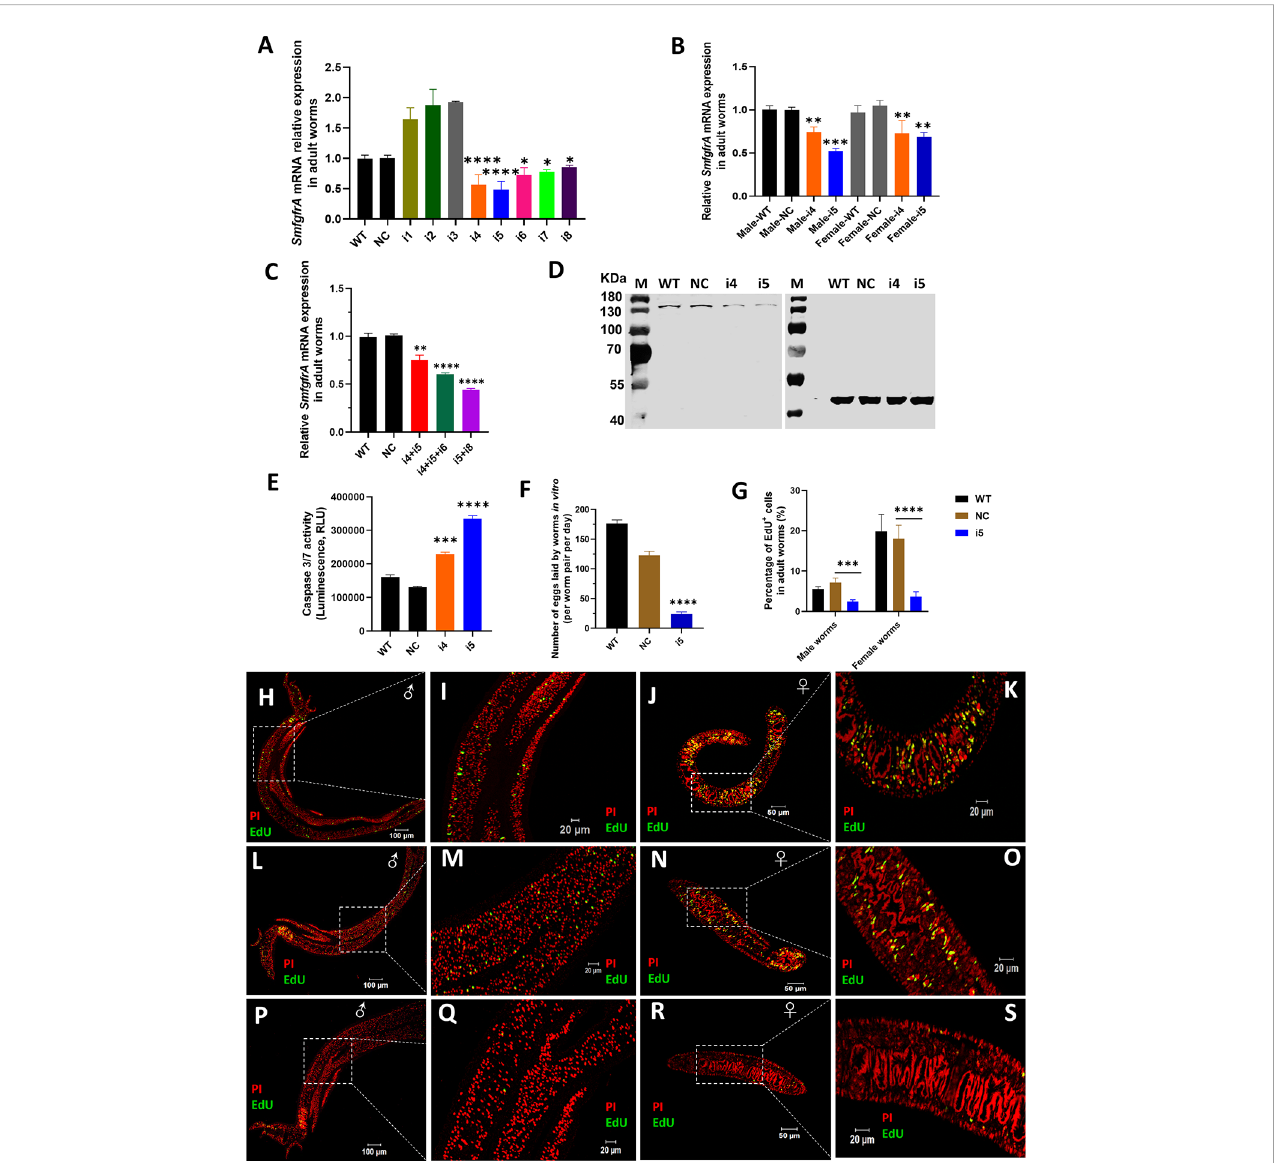
FIGURE 2 CRISPRi of SmfgfrA in S. mansoni adult worms. Transcription level of SmfgfrA was determined in (A) paired adult worms electroporated with a CRISPRi vector (PHR-SFFR-dCas9-BFP-KRAB) combined with reconstructed pg-RNA vector containing sgRNA (i1, i2, i3, i4, i5, i6, i7, i8), individually; (B) adult male and female worms treated with sgRNA i4 or i5; (C) paired worms treated with sgRNA i4+i5, i4+i5+i6, or i5+i8. Wild-type (WT) worms and worms treated with CRISPRi vector combined with pg-RNA vector containing a negative control (non-targeting) sgRNA (NC) were used as controls. Experiments in panels (A – C) were performed in triplicates and all data are shown as the mean ± SE. (D) Western blot demonstrating expression level of SmFGFRA protein in soluble worm antigen preparation (SWAP) of WT adult worms (Lane 1) and worms treated with NC (Lane 2), i4 (Lane 3) or i5 (Lane 4). An anti- actin antibody was employed to ensure equal protein loading. The electrophoresed SWAPs were transferred for the western blot analysis to two PVDF membranes which were probed simultaneously with the anti-rSmFGFRA-L antibody (left blot) and the anti-actin antibody (right blot). (E) Caspase-3/-7 activity measured in i4 and i5-treated adult worms. This assay was conducted in duplicate with all data presented as the mean ± SE. (F) The number of eggs laid by WT adult worms, NC-treated adult worms or i5-treated adult worms in vitro. This experiment was conducted in triplicates with all data shown as the mean ± SE. (G) The effect of SmfgfrA repression on the percentage of EdU + cells in i5-treated male worms and female worms. WT and NC-treated male and female worms were used as controls. Cell nuclei in all samples were also stained with Propidium iodide (PI). Percentage of EdU + cells in each sample was calculated by dividing the EdU + cell number with PI + cell number X 100. All data are shown as the mean ± SE (WT male worm: n=13, WT female worm: n=8, NC male worm: n=12, NC female worm: n=8, i5 male worm: n=10, i5 female worm: n=15). Confocal projections representative signals of EdU (green) and PI (red) in (H) WT male worm, (J) WT female worm, (L) NC-treated male worm, (N) NC-treated female worm, (P) i5-treated male worm and (R) i5-treated female worm. (I, K, M, O, Q, S) are magni fi ed squared-region in (H, J, L, N, P, R) , respectively. (Statistical signi fi cance was established employing One-way ANOVA by comparing with NC group: * p value ≤ 0.05, *** p value ≤ 0.001). ** p value ≤ 0.01, **** p value ≤